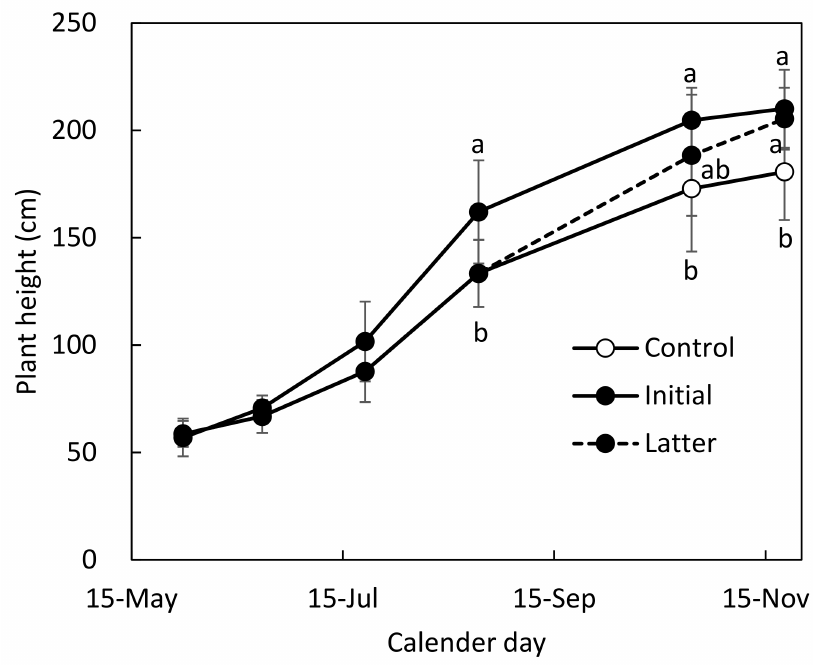
Figure 5. Changes in plant height. The value shown is an average of readings from the control (— —), initial (— • —), and latter fertilization treatments (– • –). Different letters represent statistically (cid:35) significant differences ( p < 0.05) among the